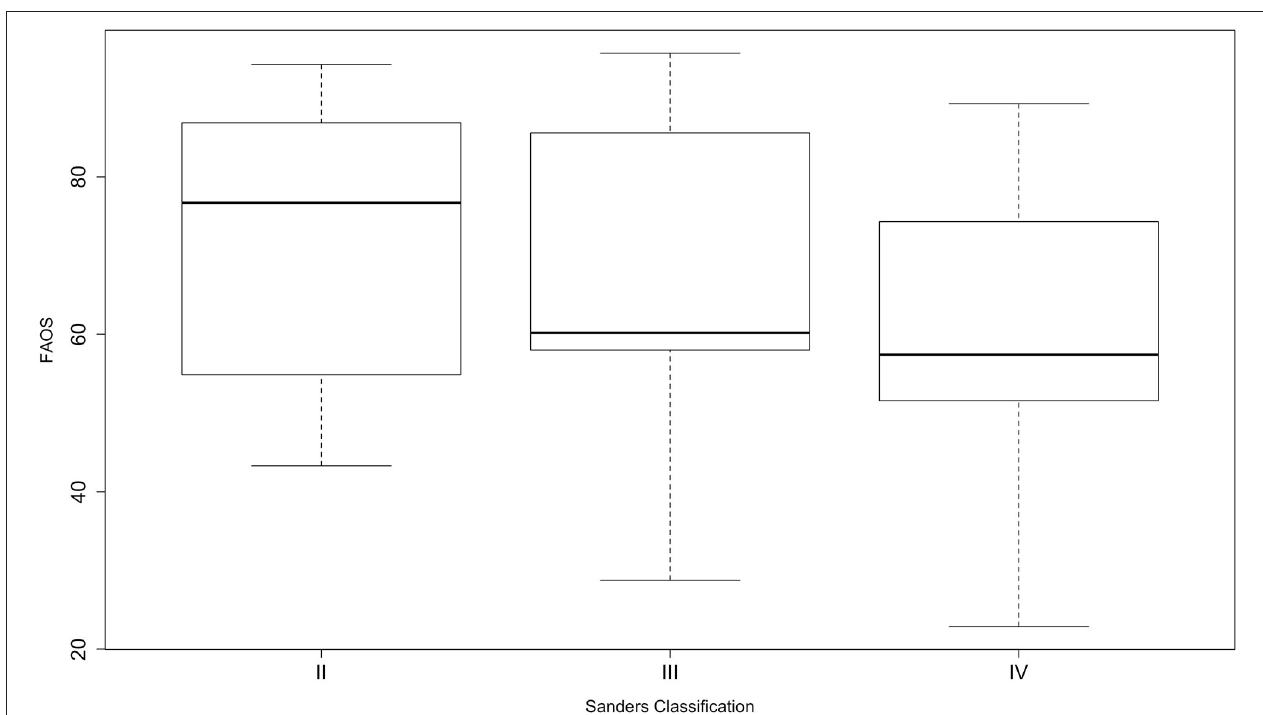
FIGURE 3 | Boxplots of foot and ankle outcome score among the different Sanders-type fractures of surgically treated patients. The whiskers show the minimum and